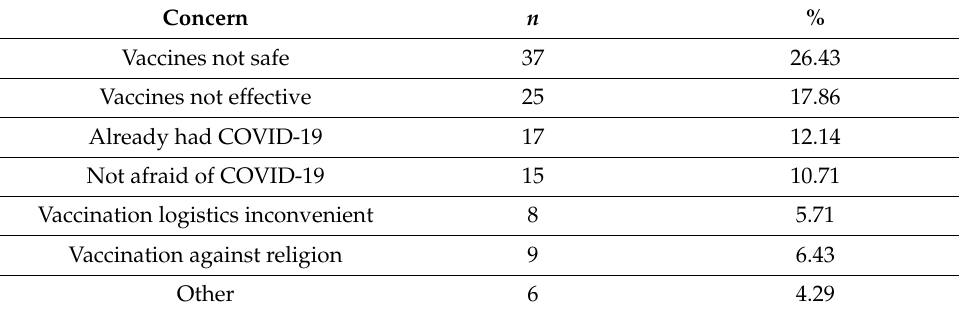
Table 10. Concerns about COVID-19 vaccines being unsafe or